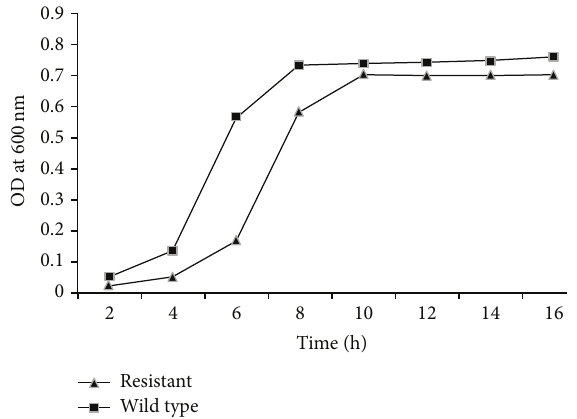
Figure 3: Comparison of growth curve of wild type and resistant S. aureus hydrophobicity may be responsible as it leads to enhanced clumping and hence provides less surface area to the microbial colony to expand.